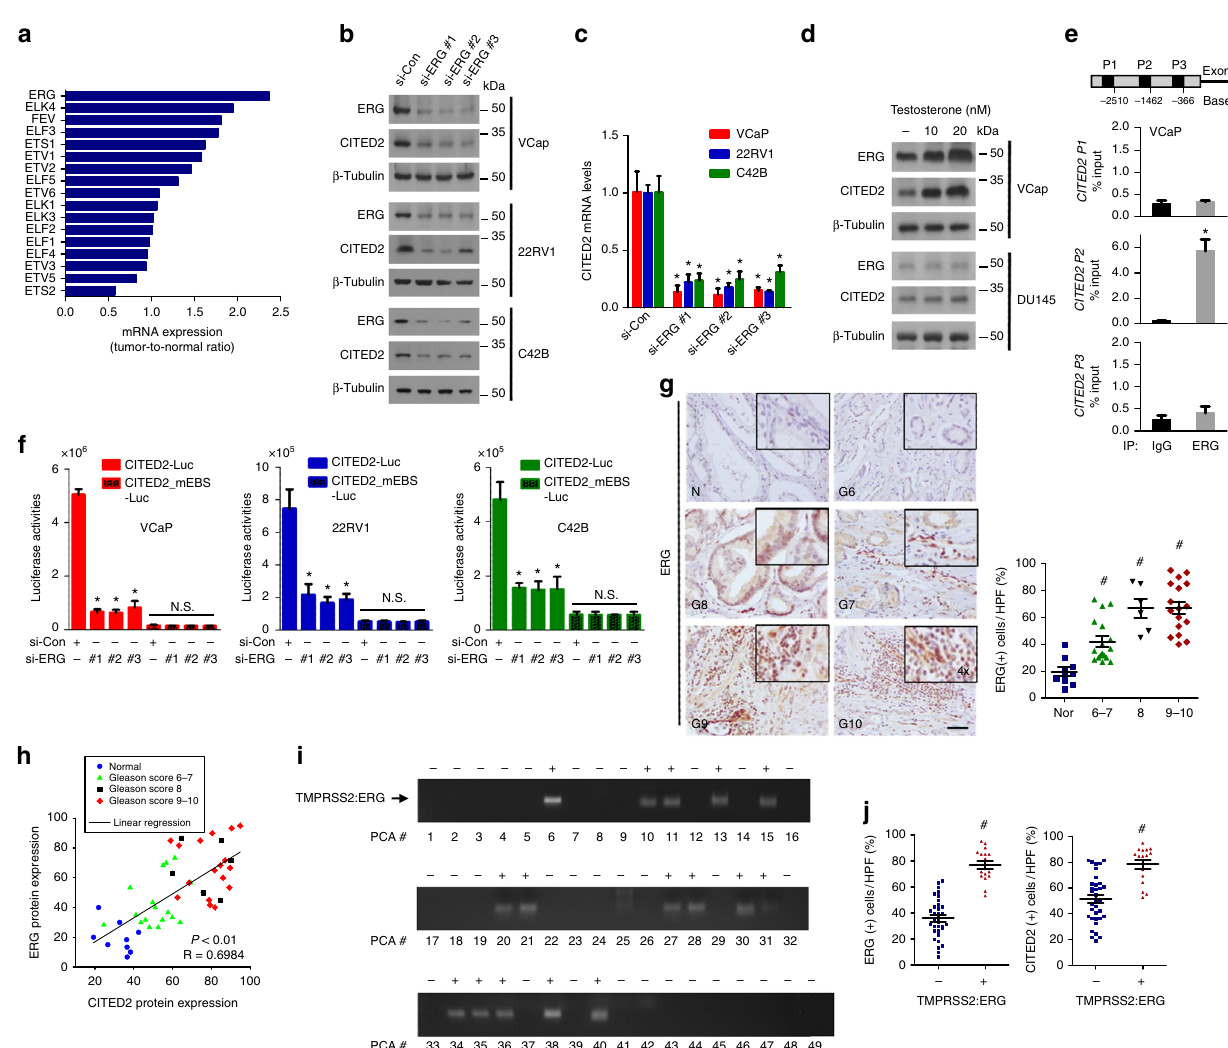
Fig. 2 ERG gene activation is responsible for CITED2 overexpression in prostate cancer. a The mRNA levels of the ETS family members in GSE6919 data set. Each bar represents the ratio of tumor level to normal level. b Indicated cells were transfected with non-targeting siRNA (si-Con) or three different ERG-targeting siRNAs (si-ERG #1, #2 and #3) at an 80 nM concentration. Cell lysates were immunoblotted using the indicated antibodies. c RT-qPCR was performed to analyze CITED2 mRNA levels in prostate cancer cells transfected with the indicated siRNAs. Each bar represents the mean + SD ( n = 3). d VCaP and DU145 cells were treated with testosterone, and the cell lysates were immunoblotted with anti-ERG, anti-CITED2, or anti- β -tubulin antibody. e The ERG binding to three CITED2 promotor regions (P1, P2 and P3) was detected by ChIP-qPCR using anti-ERG antiserum or non-immunized serum (IgG). The co-precipitated CITED2 promotor regions was quanti fi ed using RT-qPCR. Results (the mean ± SD, n = 3) were represented as percentages of IP signal/input signal (% input). * P < 0.05 versus the IgG control group. f The indicated siRNAs were cotransfected with the CITED2-luciferease or CITED2_mEBS (mutated ERG-binding sequence, patterned) reporter plasmid. Luciferase activities (mean + SD, n = 3) were measured by a luminometer. g Representative images of human prostate adenocarcinoma tissues immunostained with anti-ERG antibody. Abbreviations at the left bottoms of images: N normal prostate tissue (blue squares), G6 – 10 (6 – 7, green triangles; 8, black inverted triangles; 9 – 10, red diamond) Gleason scores 6 – 10 of prostate cancer (left panel). The immunostaining scores were calculated by counting stained cells and presented as dot plots (right panel). The scale bar represents 50 μ m. h Protein expression scatter diagrams of ERG versus CITED2. Linear regression and correlation of ERG versus CITED2. R 2 means coef fi cient of determination calculated by Pearson ’ s correlation. i DNAs extracted from prostate cancer tissues were subjected to PCR using a forward primer binding to the TMPRSS2 promoter and a reverse primer binding to the ERG gene. The PCR products of the TMPRSS2 – ERG fusion gene ( + , positive; − , negative) are indicated as an arrow. j The immunostaining scores were calculated by counting stained cells. Blue and red symbols indicate ERG (right panel) and CITED2 (left panel) levels in the TMPRSS2 – ERG fusion negative (blue squares) and positive (red triangles) group. The horizontal lines in all dot plots represent the means ± SE and # P < 0.05 versus the normal group by Mann – Whitney statistical analysis; * P < 0.05 versus the si-Con group by Student ’ s t -test; N.S. ‘ not signi fi cantly different ’ among the